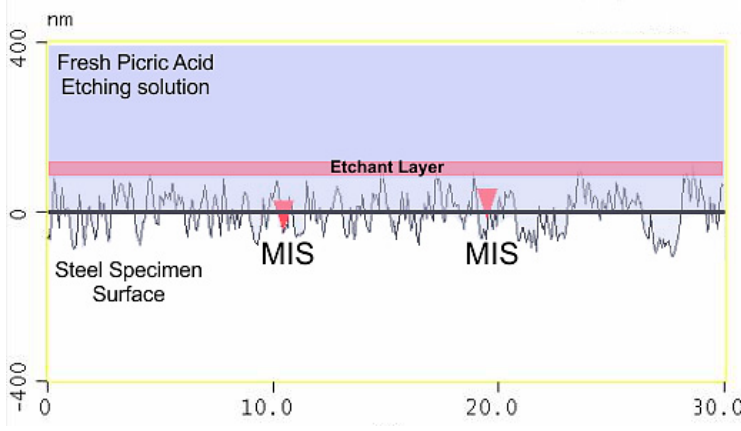
Figure 15. Illustration of the unsuccessful etching mechanism using atomic force microscopy (AFM).